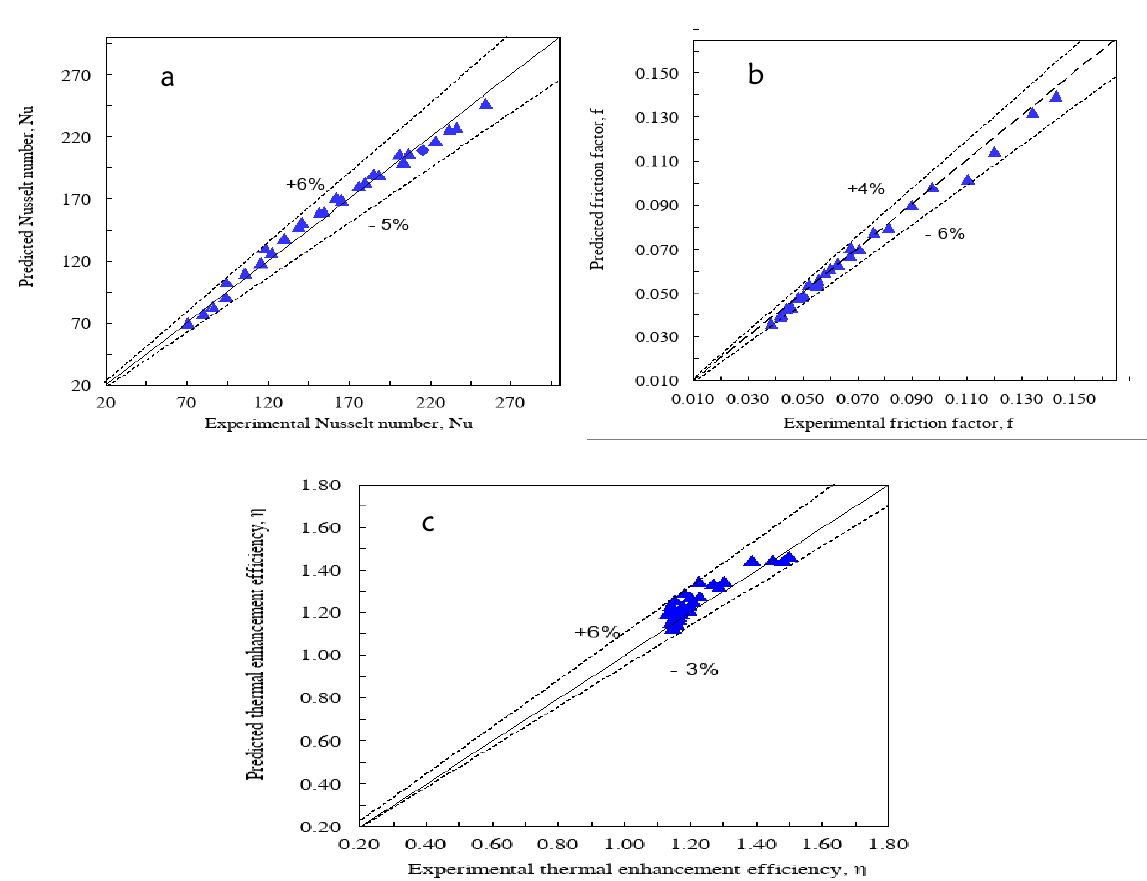
Paneliya et al., [13] found 1.27 times larger heat transfer enhancement for X-Shaped tapes than twisted tape inserts by comparing the thermal characteristic of water flowing in a tube equipped with X-tape and twisted tape to investigate the effect of insert tape geometry on the heat exchanger tubes [13]. The material of the insert tapes was stainless steel in this study. The thermal performance of the heat exchanger tube has been analyzed for this experiment in terms of heat transfer rate (Q), Nusselt Number (Nu) and friction factor (f). The investigation also conducts a CFD analysis to validate the obtained results and observed that the modified geometry of tapes played a vital role to enhance the heat transfer characteristic and thermal performance where turbulence intensity occurred, showed in Figure